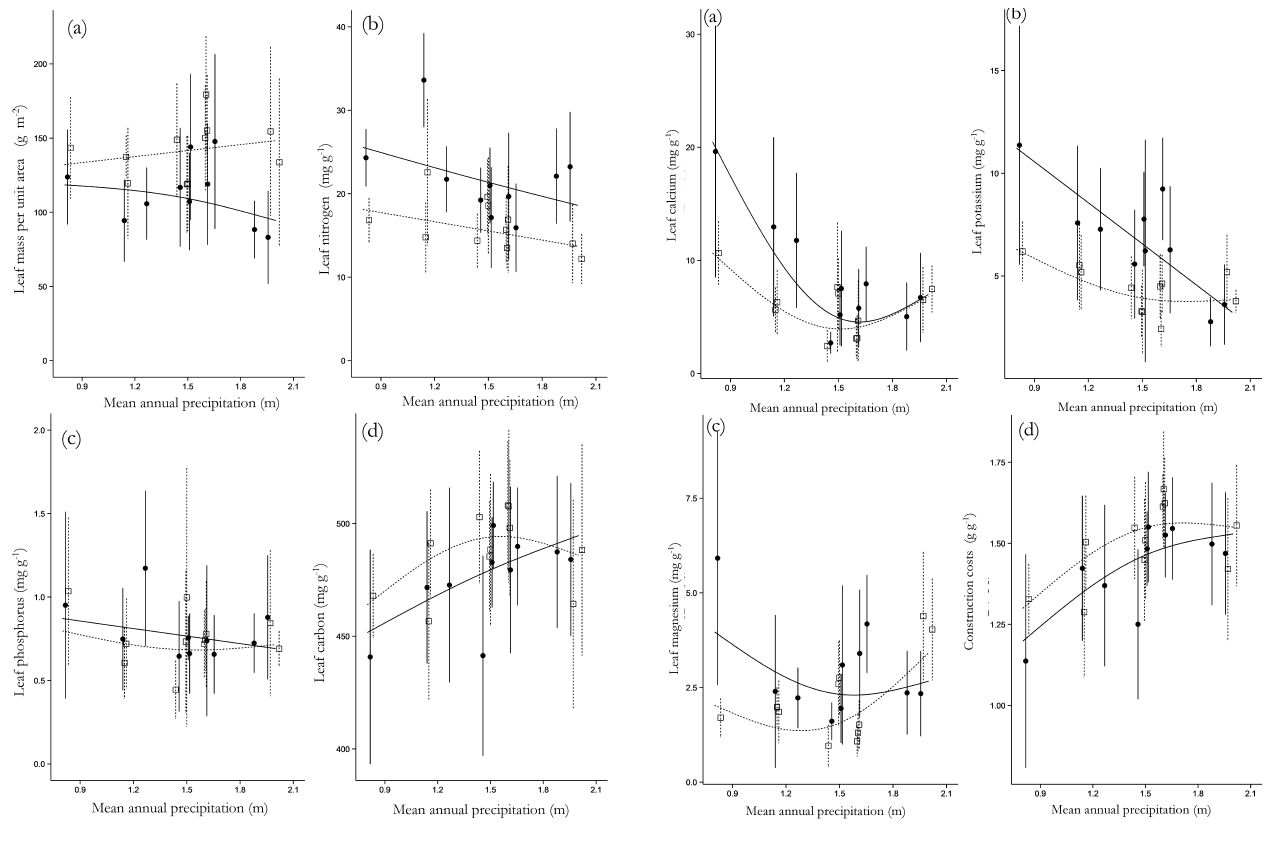
Figure 6. Variations in community-abundance-weighted mean fo- liar properties in relation to precipitation and vegetation formation type (a) leaf mass per unit area, (b) leaf nitrogen (dry-mass basis), (c) leaf phosphorus (dry-mass basis) and (d) carbon (dry-mass ba- sis). ( • ) Forest plots; ( (cid:3) ) savanna plots. Fitted curves (solid for for- est plots, dashed for savanna) represent generalised additive model fits. Error bars represent the community-abundance-weighted SD.